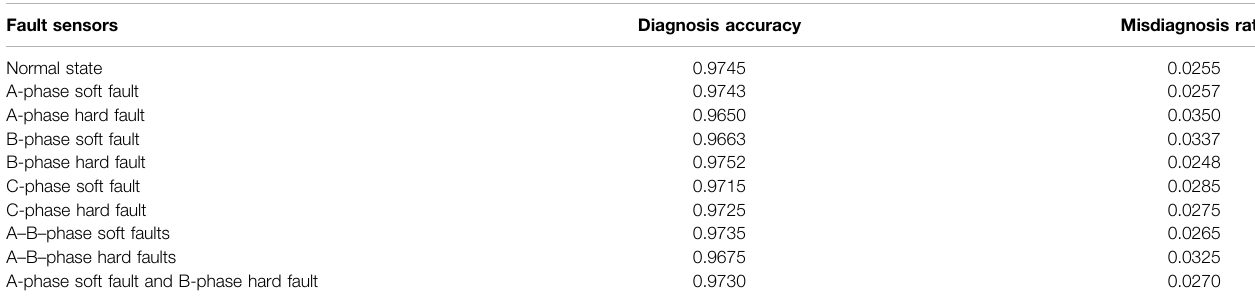
TABLE 4 | Accuracy of RFs with current fault texture